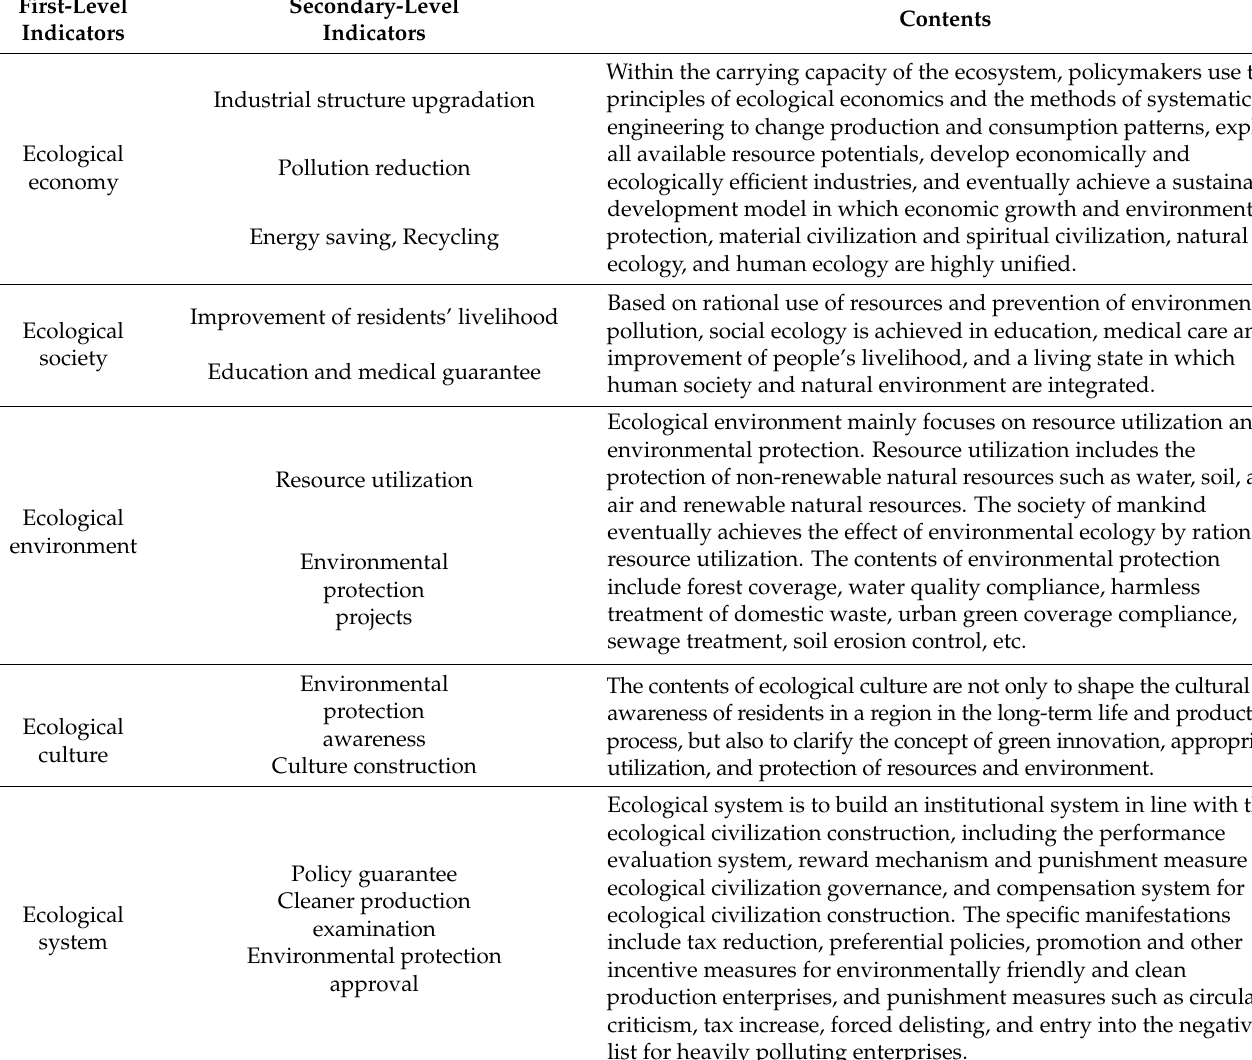
Table 1. The construction contents of